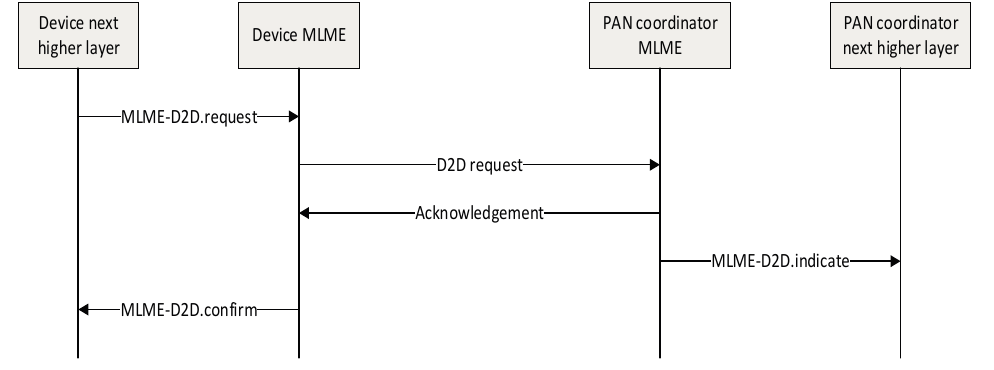
Figure 10. Message sequence chart for D2D deallocation initiated by a